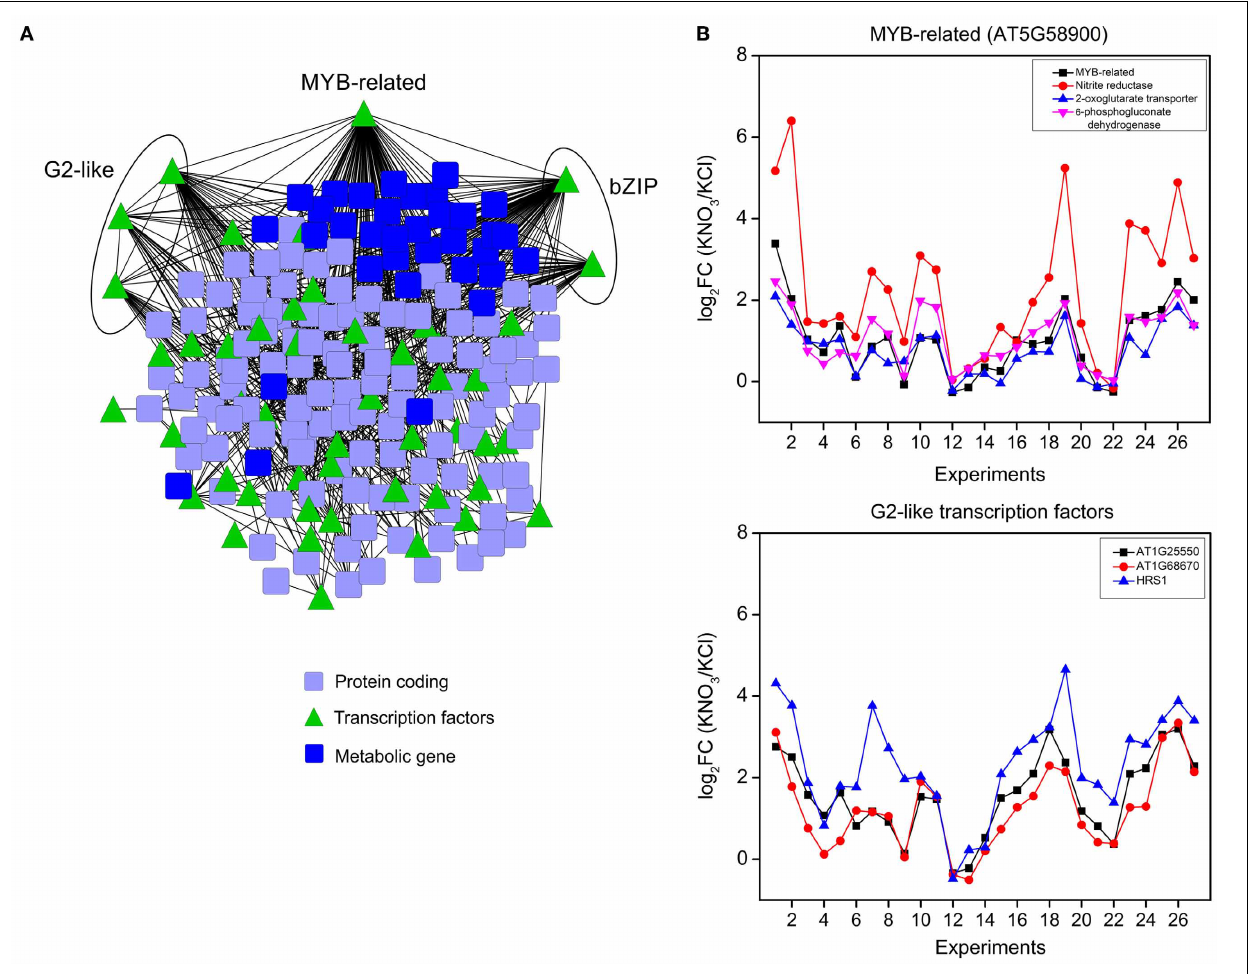
FIGURE 5 | Transcriptional control of the central modules in the nitrate gene network. (A) A subnetwork of transcription factors and their potential targets derived from modules 1, 7, 8, and 9. Edges represent predicted regulatory interactions between transcription factors and target genes based on overrepresented transcription factors binding